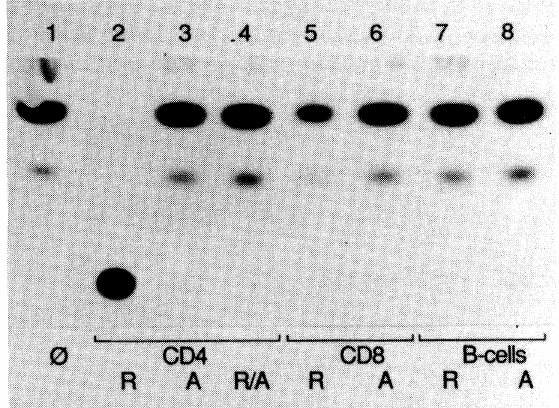
FIG. 4. Functional tests of TFs in the oocyte system. Proteins (5 ng) from the different T-cell subsets in their resting (R) or activated (A) phase, were injected into the oocyte cytoplasm, followed by injection of 2 ng of 4 Pud-CAT gene constructs into the oocyte nucleus. For the CD4/CD8 group, following injection of silencer and the gene, extract from activated cells was added in a third, cytoplasmic, injection to test for derepression (R/A). The symbols used for protein extracts are the same as in Fig. 2. CAT assays yield three forms of acetylated chloramphenicol (lowest spot, not converted; second spot, 1-; third, 3-, fourth; 1-3-acetylation). Activity was measured on aliquots corresponding to one oocyte taken from lysates produced from 10-15